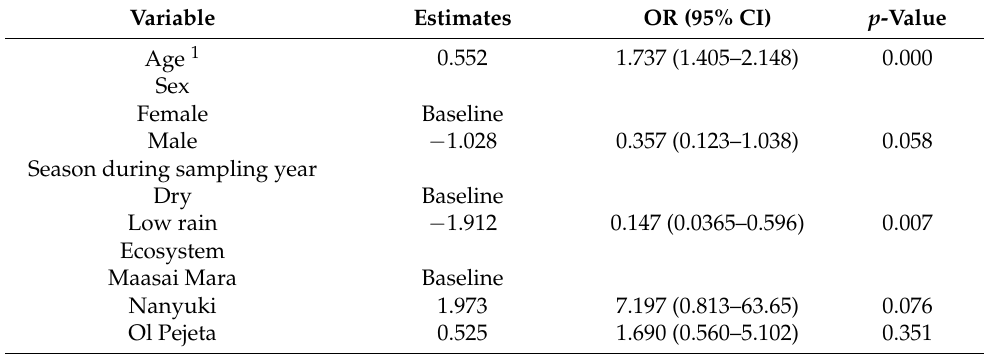
Table 4. Multiple logistic regression analysis for association between studied variables and CCHF serological outcomes in